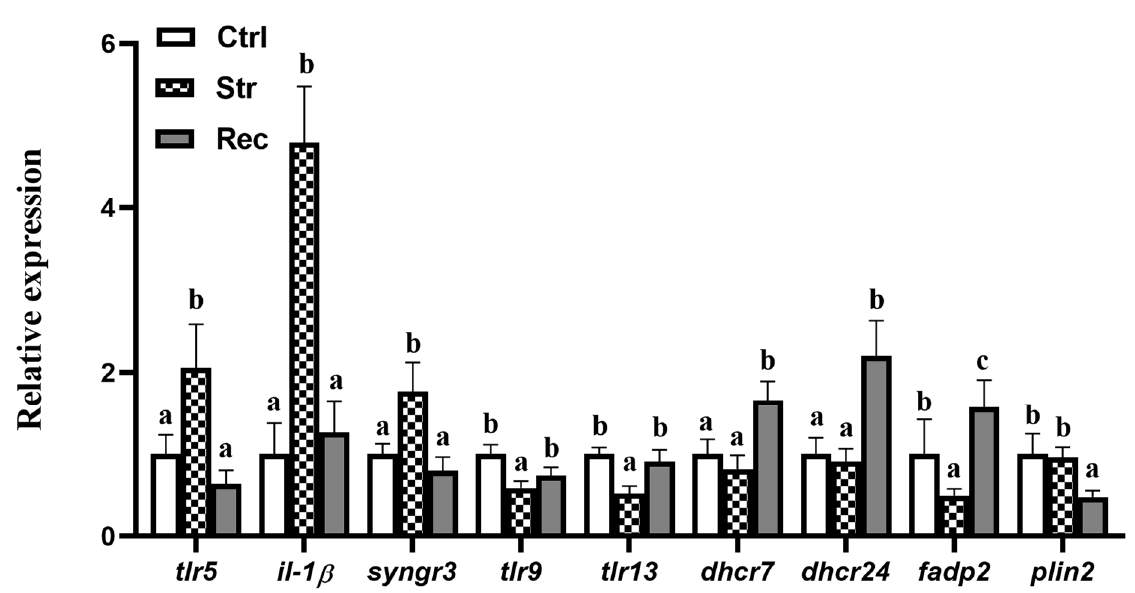
Figure 5. Expression levels of tlr5 , tlr9 , tlr13 , il1 β , syngr3 , fabp2 , plin2 , dhcr7 and dhcr24 mRNA (n = 9 replicates) in Ctrl (control groups), Str (transport groups), and Rec (recover groups). Different letters indicate statistical significance ( p < 0.05) among the three groups.